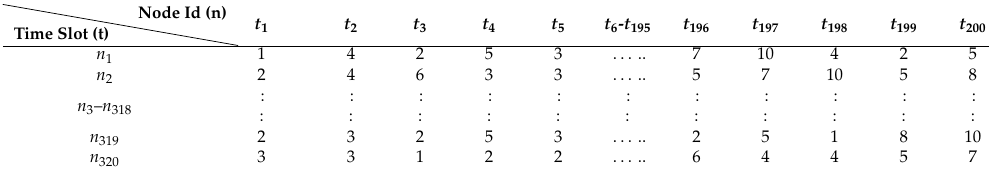
Figure 2. Duplicate Intersection Sets. The surface chart represents the example of duplicate intersection detected by each node for each time slot obtained from the simulation. The legend shows the range of duplicated intersection sets detected, defined by different colors. The results vary depending on the location and movements of each node during the simulation. Table 3. Sample of Duplicate Intersection Sets extracted from Figure 2. t and n represent the Time Slot and the Node Id, respectively. The correspondence values between the Time Slot and the Node ID represent the number of duplication detected for the node in each time slot.